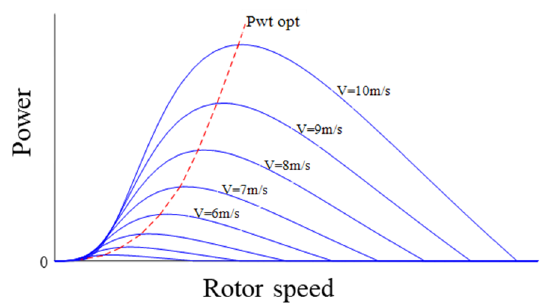
Figure A2. Power-Rotor Speed